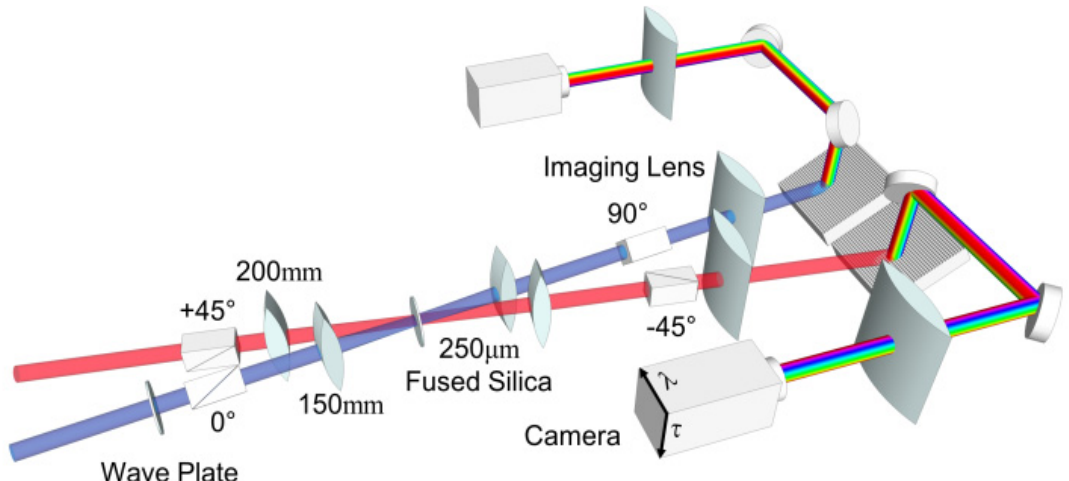
Figure 12. The schematic of single-shot DB PG FROG for measuring an unknown pulse pair at different wavelengths (400 nm and 800 nm in the actual experimental demonstration) [26].